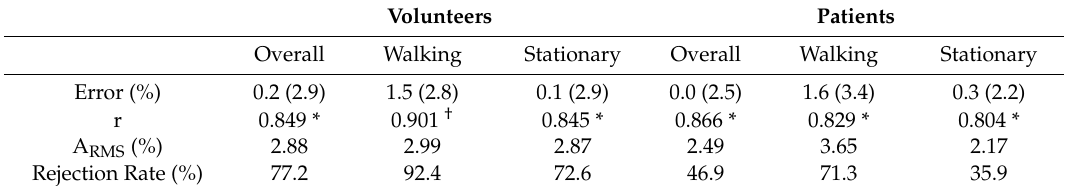
Table 1. Performance of OxyFrame compared to a standard pulse oximeter (MASIMO) for walking and stationary activities. The error values are shown as mean (standard